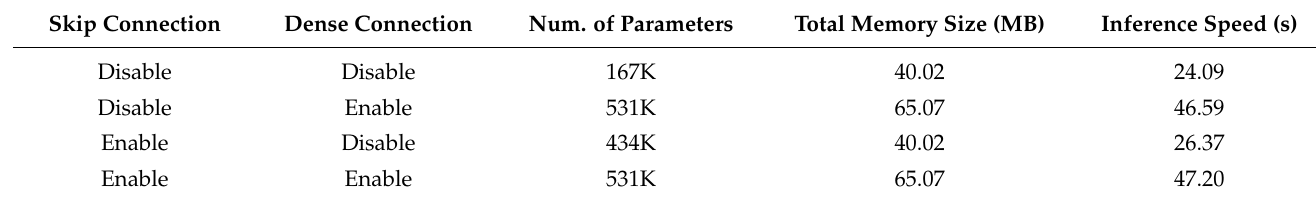
Table 11. Network complexity and inference speed on BSD100 according to tool-off